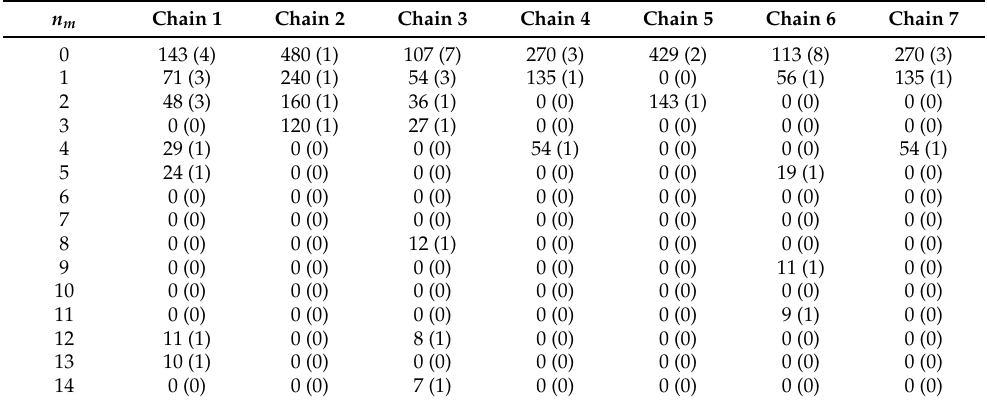
Table A1. In the infection network shown in Figure 3, the reward for n m of each chain was presented rounding off to the first decimal place with w = 1, and the numbers in parentheses are the number of people receiving the corresponding